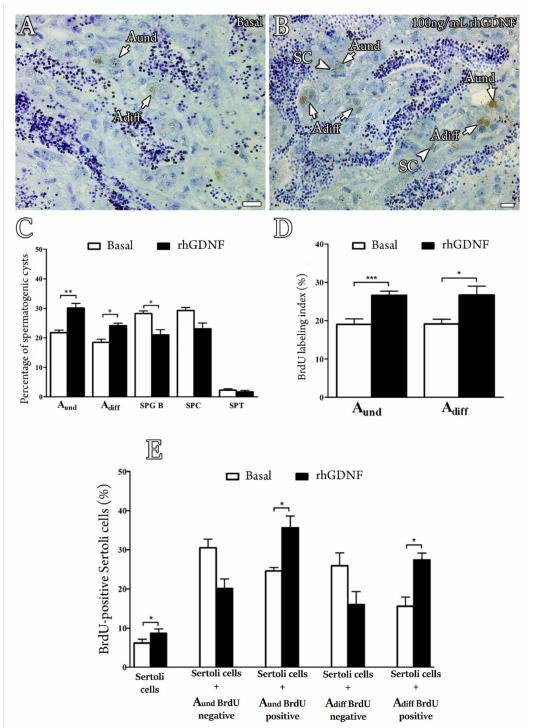
Figure 7. Effects of Gdnf on germ cell composition and cellular proliferation, using a previously established primary testis tissue culture system. ( A , B ) BrdU immunodetection from zebrafish tes- ticular explants incubated for 7 days in the absence (Basal) or presence of rhGDNF (100 ng/mL), demonstrating a higher proliferation activity for type A undifferentiated spermatogonia (A und ) and type A differentiated spermatogonia (A diff ) in the presence of rhGDNF. ( C ) Frequency of different germ cell cysts after 7 days of incubation in the absence (Basal) or presence of rhGDNF (100 ng/mL). Types A und , A diff and B spermatogonia (SPG B), spermatocytes (SPCs) and spermatids (SPTs) were identified according to morphological characteristics, as described by Leal and collaborators